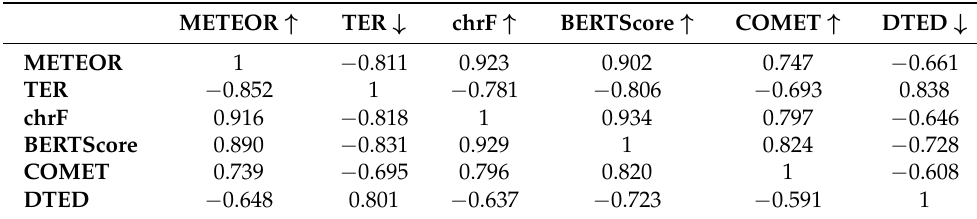
Table 8. Pearson correlations between the automatic evaluation scores per sentence calculated both for baseline NMT ( lower left ) and NFR outputs ( upper right ). METEOR ↑ TER ↓ chrF ↑ BERTScore ↑ COMET ↑ DTED ↓ METEOR